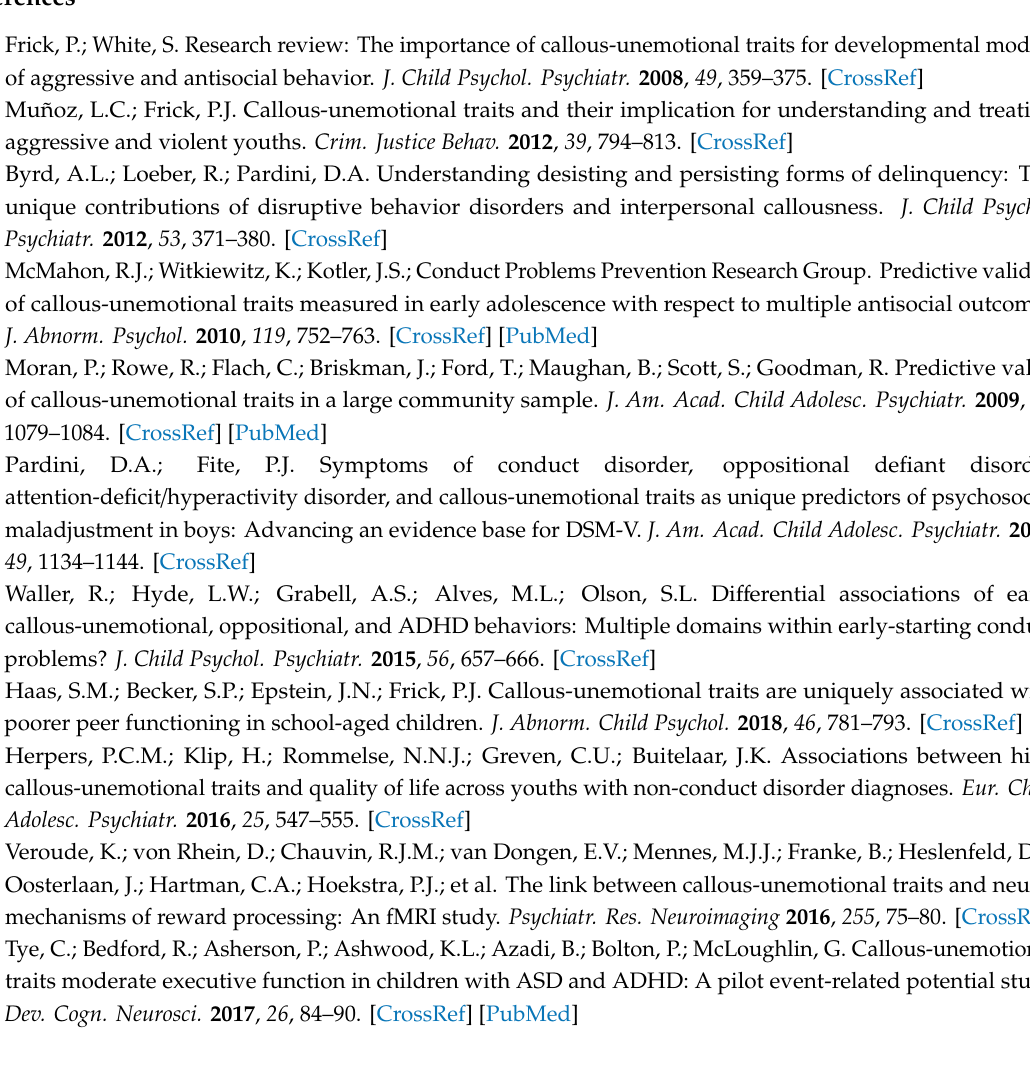
Table S1: Adolescent–parent agreement ratings on every items of the Chinese version of the Inventory of Callous and Unemotional